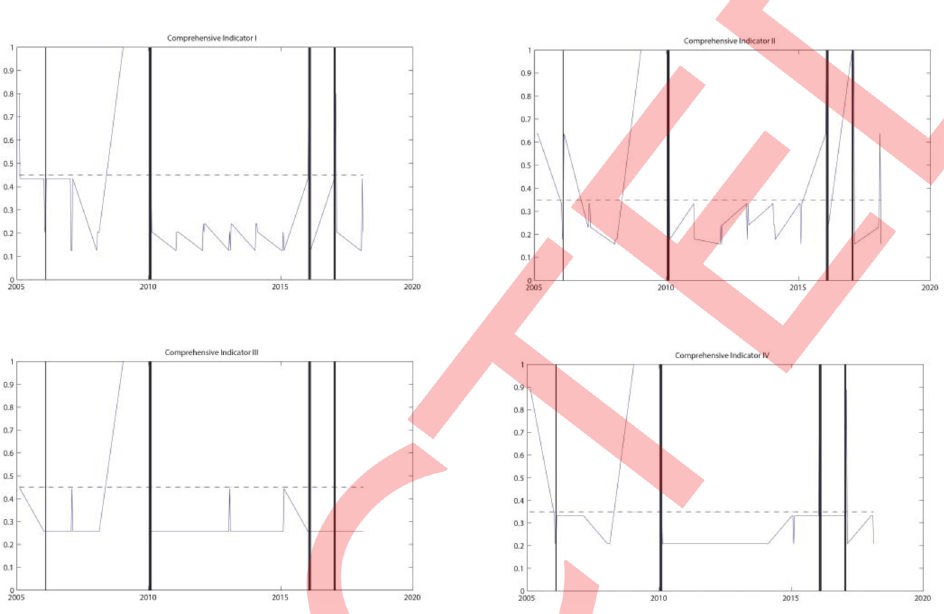
Fig 4. Probability forecasts of housing price crises for Tianjin. The shaded regions represent the time spans of housing price crises. The solid lines are the forecasted probabilities from the four comprehensive indicators with the threshold level of k = 1. Correspondingly, the dashed lines are their cut-off